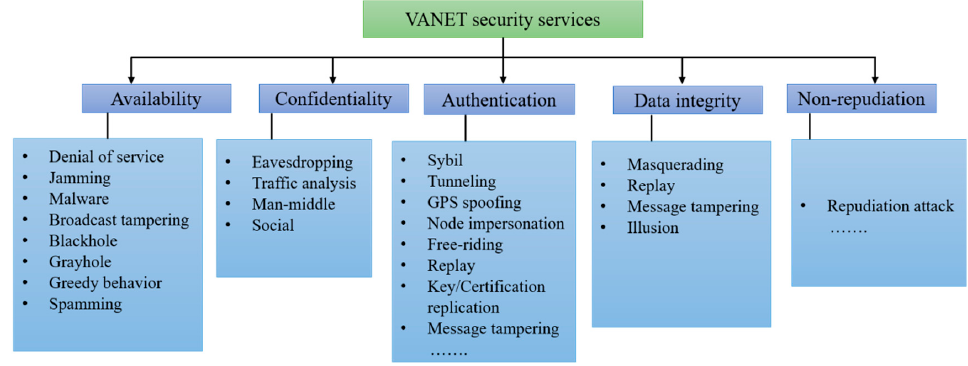
Figure 4. VANET security